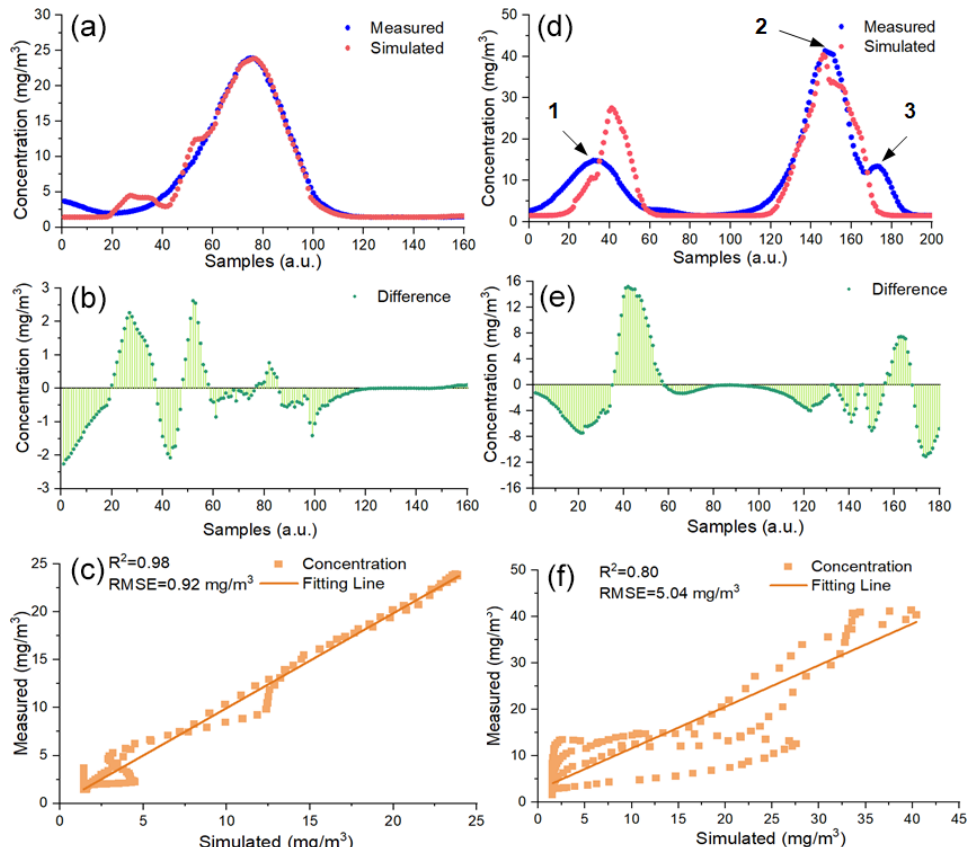
Figure 6. Comparison between the measured samples and the simulated ones based on the ERA5 meteorological data: (a) Flight 6 and (d) Flight 15. The difference between simulated CH 4 concentration data and actual measured ones: (b) Flight 6 and (e) Flight 15. Correlation analysis: (c) Flight 6 and (f) Flight